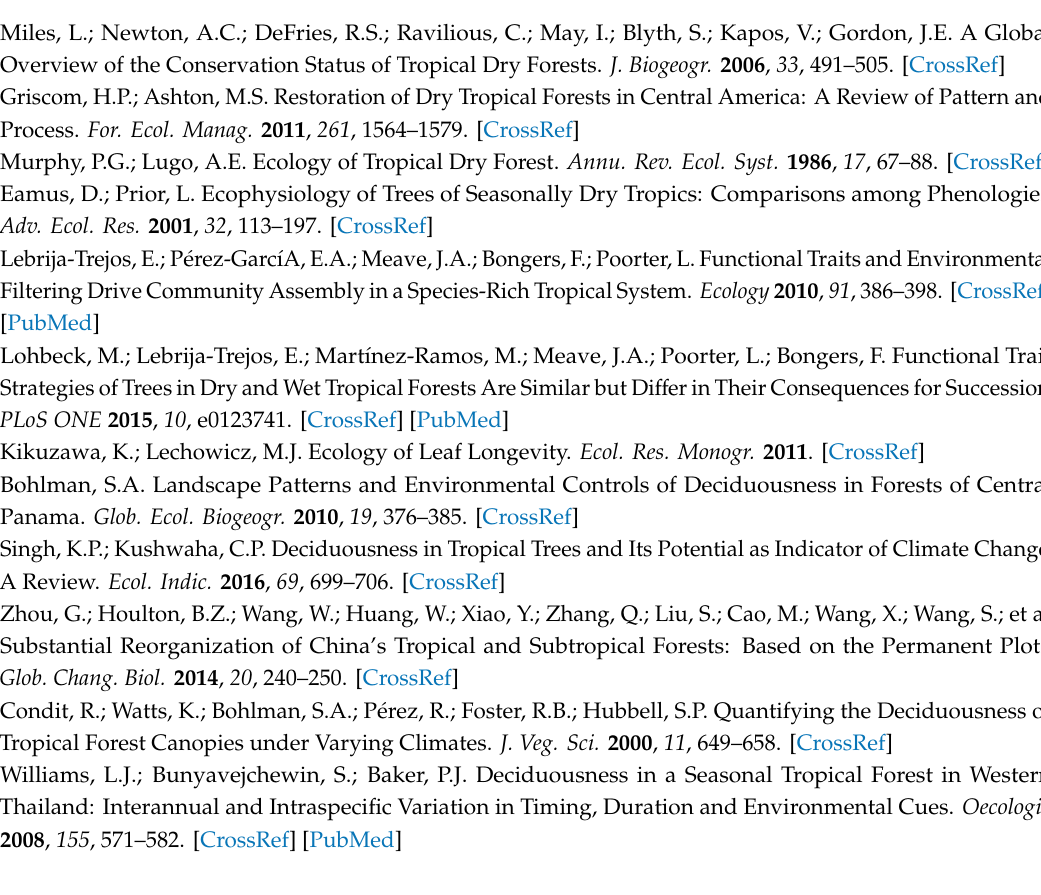
Table S1: Foliar habit of the species recorded in this